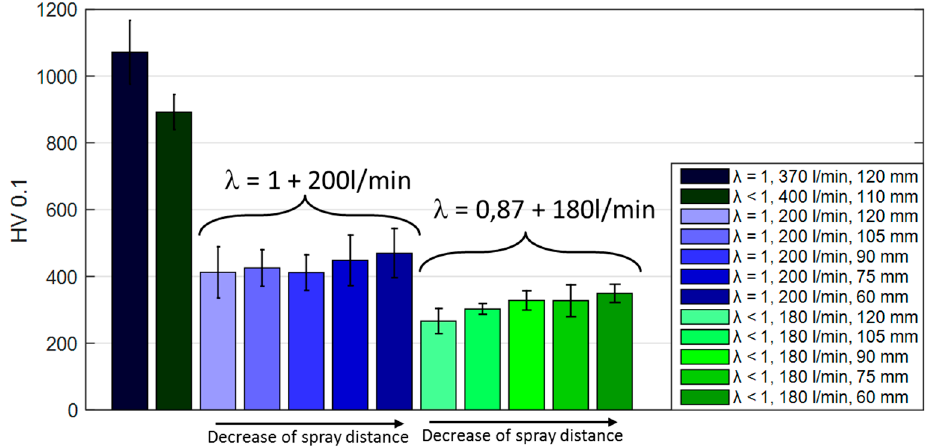
Figure 7. Comparison of Vickers hardness HV0.1 for NiCr coatings sprayed with different λ (0.87 and 1) and at different spray distances (60; 75; 105; 110; 120 mm).